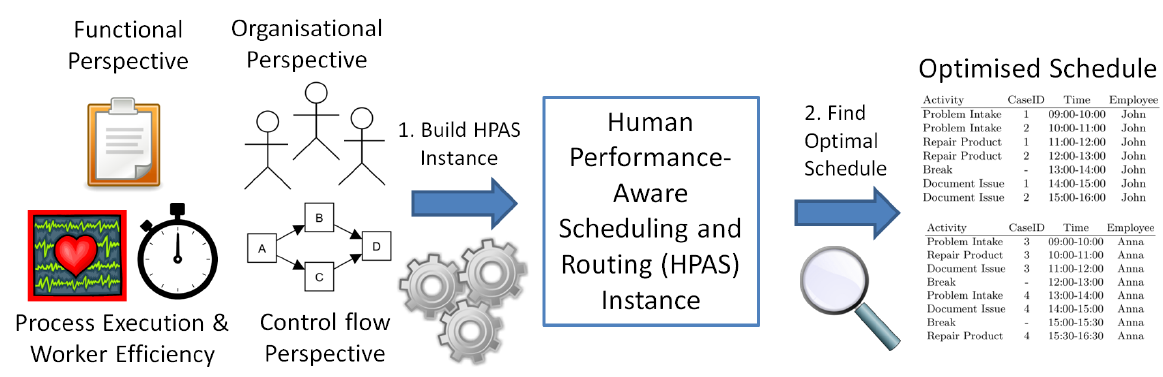
Figure 1. An overview of the use of business process knowledge in scheduling. To create the HPAS problem instance as specified in Section 2 we need to determine various input parameters that can be linked to specific aspects from the field of process